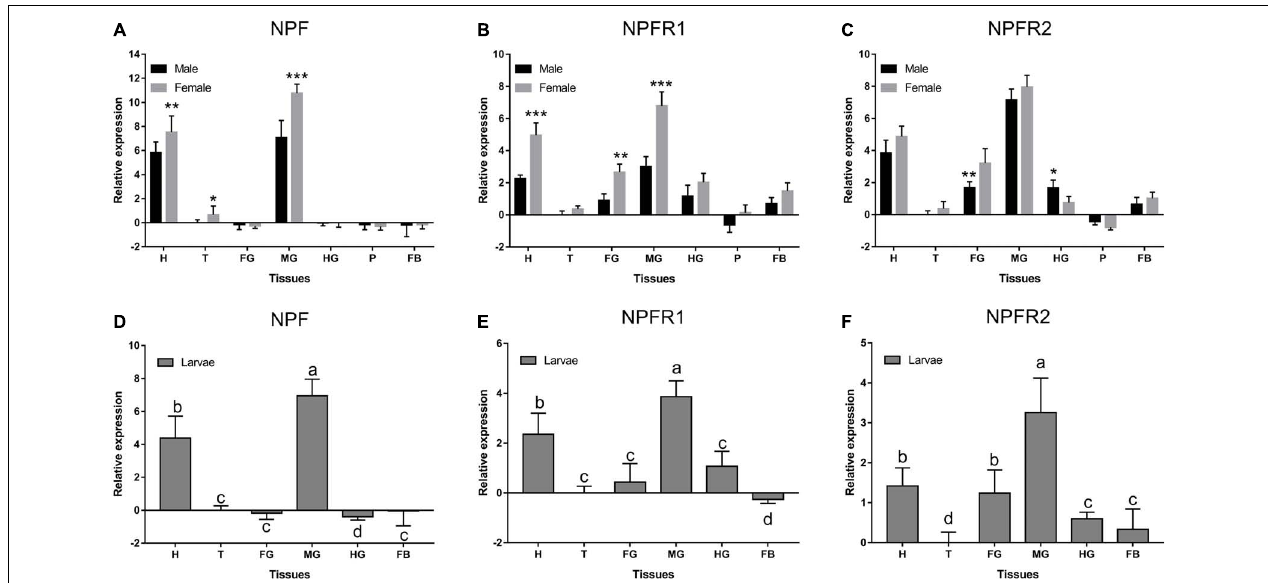
FIGURE 2 | Relative expression levels of emerged adults of NPF (A) , NPFR1 (B) , NPFR2 (C) , and larvae of NPF (D) , NPFR1 (E) , and NPFR2 (F) in different tissues of D. armandi. The relative expression levels were normalized with β -actin and CYP4G55 using the expression levels in the thorax for calibration. Different lowercase letters indicate significant differences at the 0.05 level. The asterisk indicates a significant difference between female and male expression levels (* P < 0.05, ** P < 0.01, *** P < 0.001, independent Student’s t -test). All values are mean ± SE , n = 3. H, head; T, thorax; FG, foregut; MG, midgut; HG, hindgut; P, pheromone gland; FB, fat body.